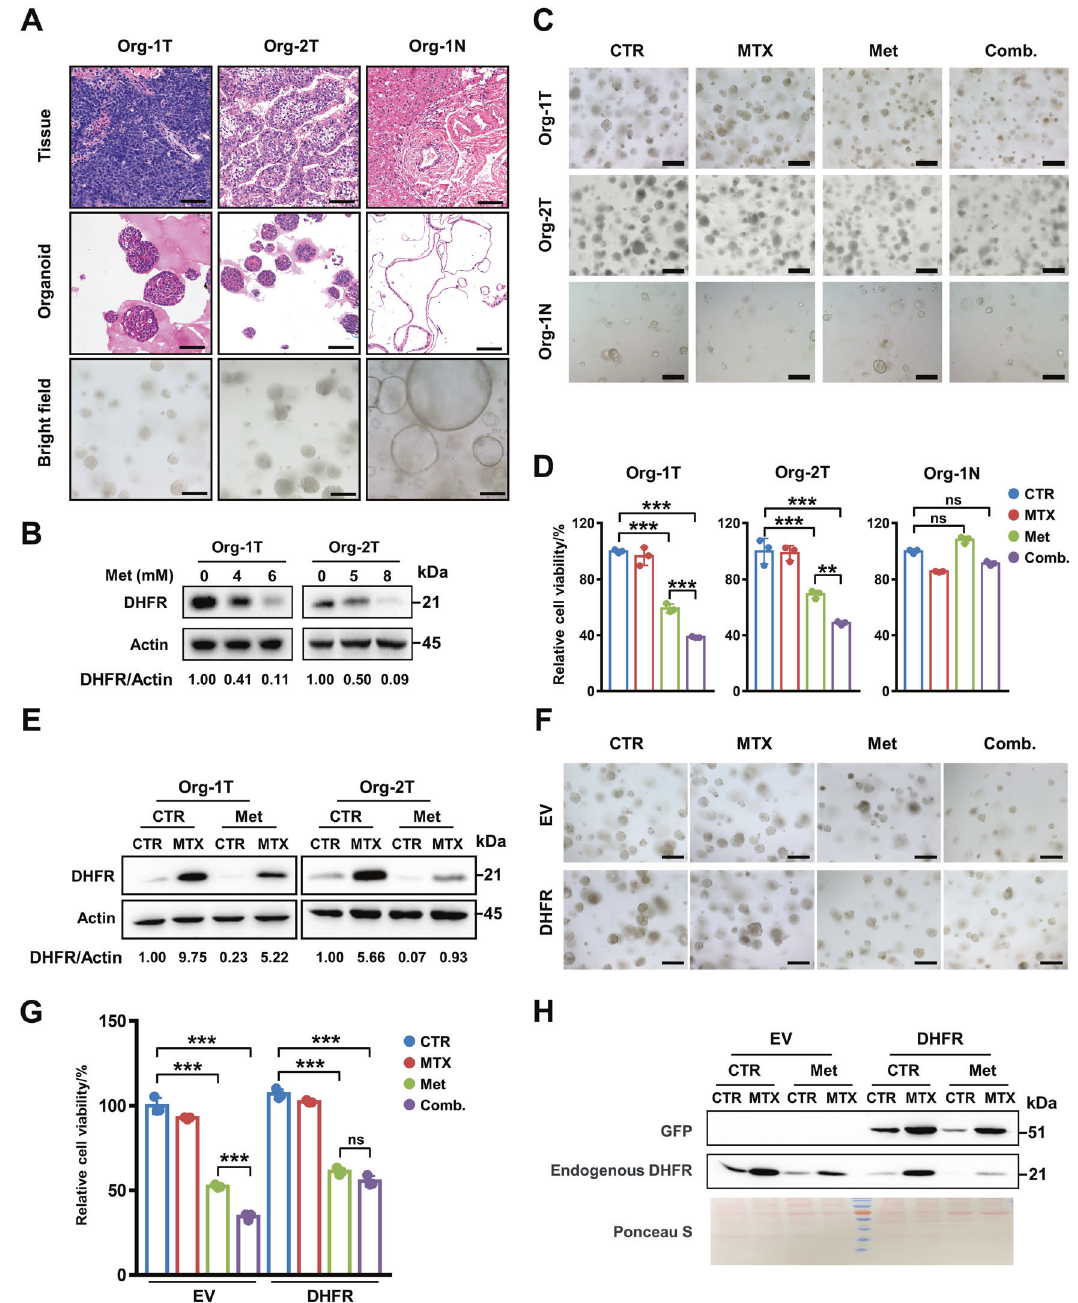
Fig. 5 Metformin enhances sensitivity to MTX in patient-derived organoids by decreasing the DHFR level. A H&E staining of original tissue and organoids; bright- fi eld images of Org-1T, Org-2T and Org-1N. Scale bar, 50 μ m for H&E staining images and 100 μ m for bright fi eld images. B Western blot analysis of DHFR expression in Org-1T and Org-2T under treatment with different doses of metformin as indicated. C – E Org-1T, Org-2T and Org-1N were treated with DMSO, MTX (15 nM for Org-1T and 30 nM for Org-2T and Org-1N), metformin (4 mM for Org-1T and 5 mM for Org-2T and Org-1N) or a combination of MTX and metformin for 6 days. Then, representative bright- fi eld images ( C ), relative cell viability ( D ) and DHFR expression in Org-1T and Org-2T ( E ) were analysed. Org-1N was differentiated into hepatocytes before treatment. Scale bar, 100 μ m. F – H Org-1T expressing GFP-EV or GFP-DHFR was treated with DMSO, MTX (15 nM), metformin (4 mM) or a combination of MTX and metformin for 6 days. Then, representative bright- fi eld images ( F ), relative cell viability ( G ) and expression levels of GFP and endogenous DHFR ( H ) were analysed. Scale bar, 100 μ m. Ponceau S staining was used as the loading control. Band intensities for protein expressions in the western blot assay were quantitated by ImageJ and normalised to Actin. Data are presented as the mean (±SD) values. Statistical signi fi cance was assessed by ANOVA followed by Tukey ’ s multiple comparisons test or non-parametric test. ** and *** indicate P < 0.01 and 0.001, respectively, compared between the indicated groups. ‘ ns ’ indicates no signi fi cant difference between the indicated